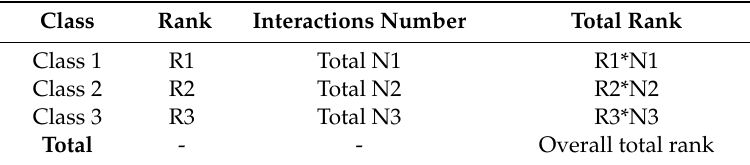
Table 4. Learners’ interactions ranking.